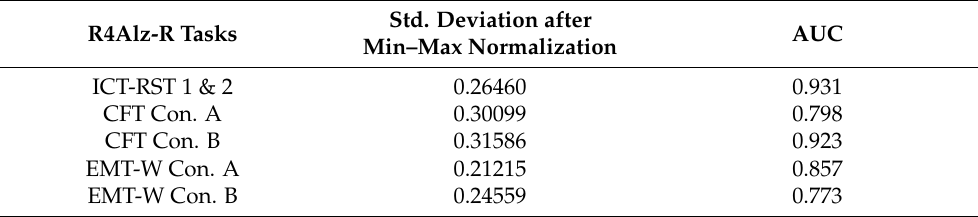
Table 9. Standard deviations of the R4Alz battery’s scores of interest for HC and MCI groups.